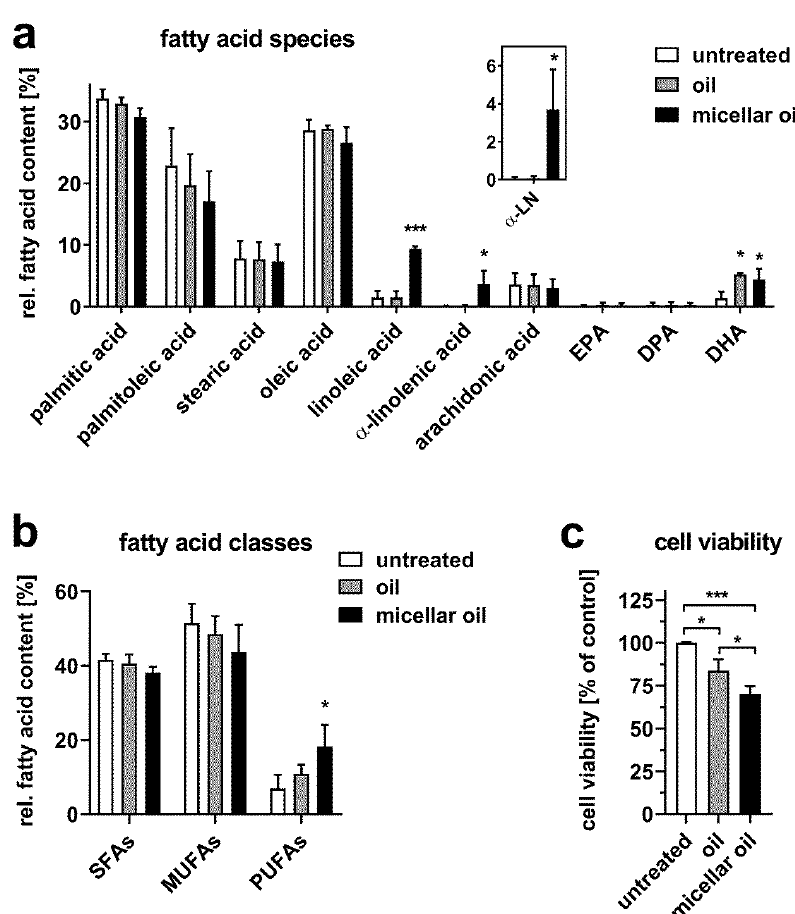
Figure 1. Uptake of fatty acids from algae oil into di ff erentiated Caco-2 cells. Cells were incubated with native or micellar oils at a final concentration of 1% for 6 h. Total fatty acid content was measured by GC-MS. The relative fatty acid composition ( a ) and distribution of fatty acid classes ( b ) are shown. The inset indicates an enlarged view on α -linolenic acid ( α -LN) levels. Cell viability was assessed after incubation with 1% oil or micellar oil for 24 h ( c ). Data are derived from three independent experiments. Bars represent mean ± SD. Asterisks indicate statistically significant di ff erences from untreated controls. *** p < 0.001 and * p <